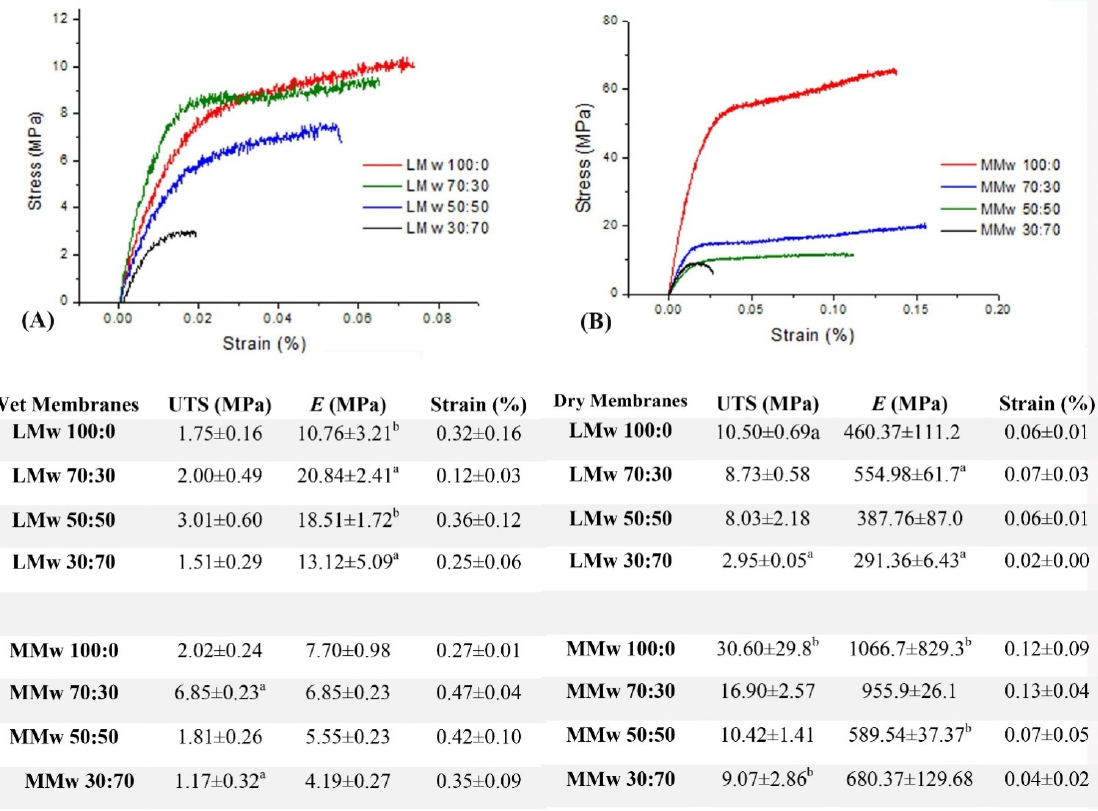
Figure 4. The correlation of stress to strain. ( A ) Representation of the LMw composite membranes in wet conditions, ( B ) representation of the MMw composite membranes in dry conditions. Results of the tensile test are shown in the table, values are a mean ± SD ( n = 6). Ultimate tensile strength (MPa), Young’s Modulus ( E ) or Elastic Modulus (MPa) and Strain (%). Similar superscripted letters in the same column indicate statistical significance ( p < 0.05).